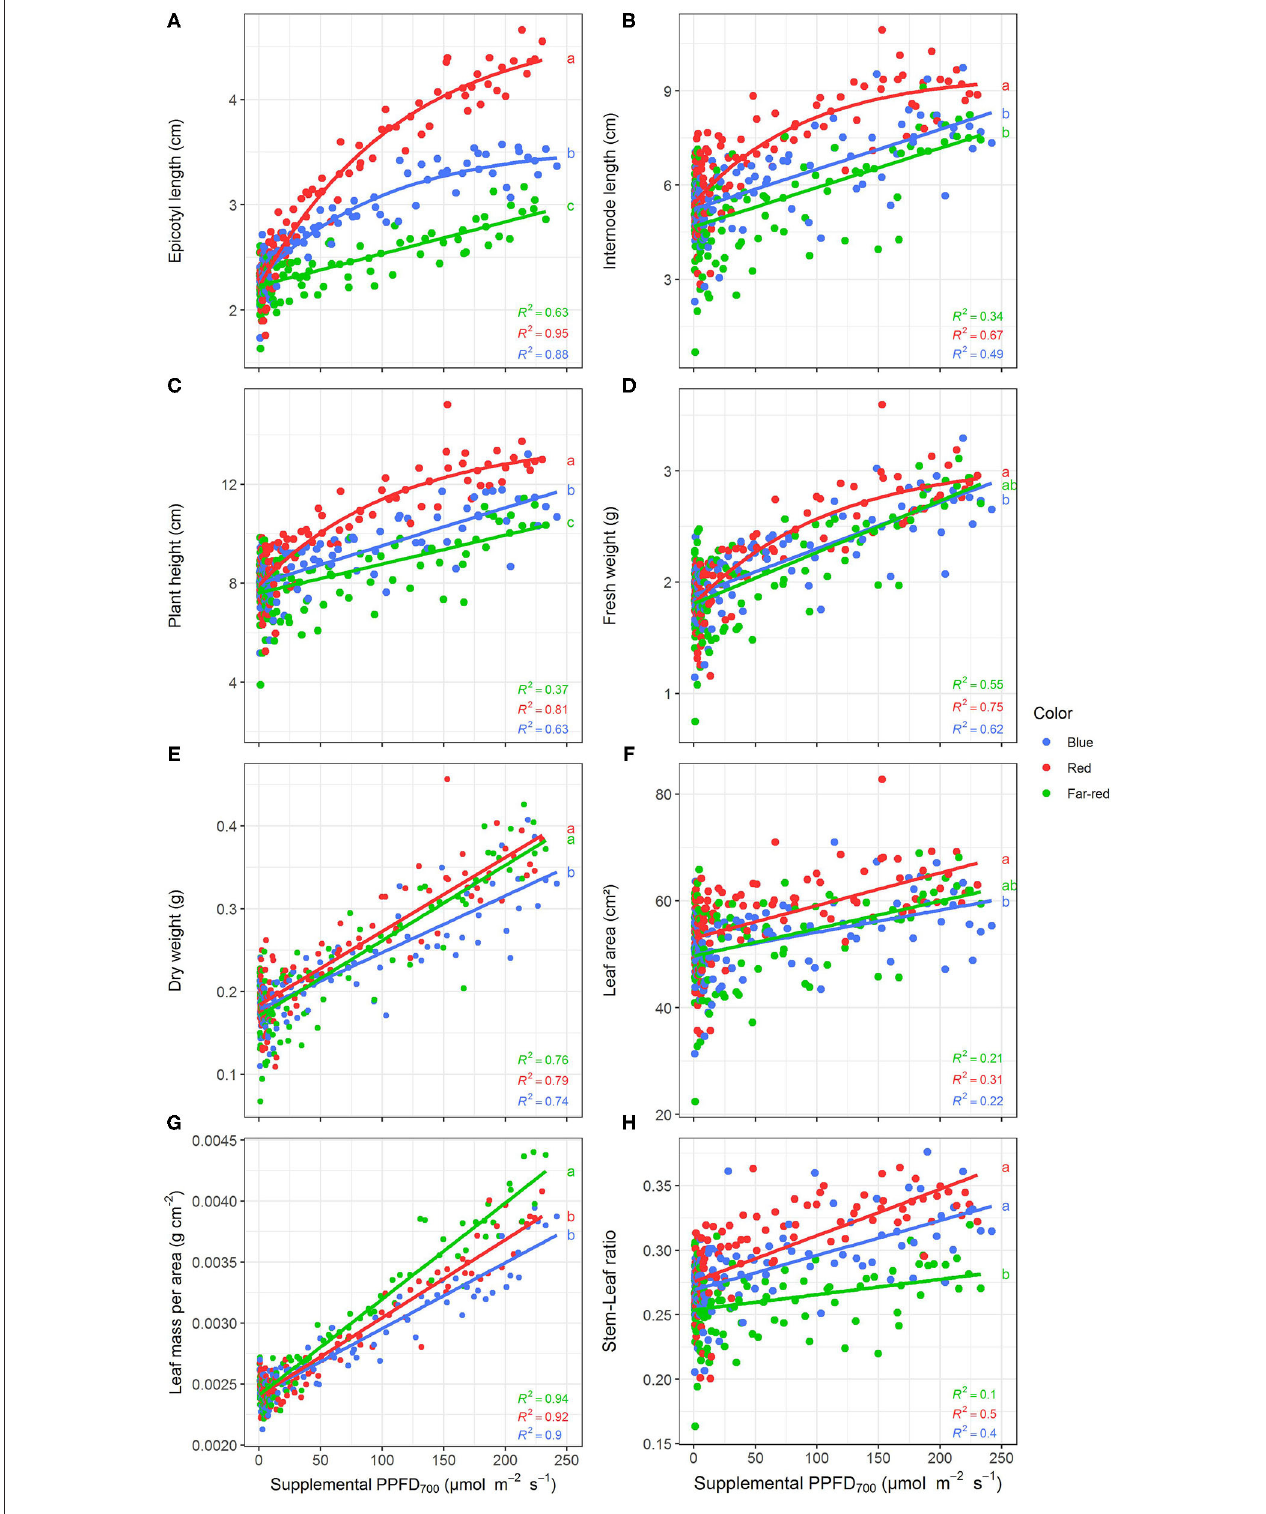
FIGURE 3 | Effect of supplemental PPFD 700 (400–700nm) with different spectra on epicotyl length (A) , total internode length (B) , height (C) , fresh weight (D) , dry weight (E) , leaf area (F) , leaf mass per area (G) , and stem-leaf ratio (H) of Ocimum basilicum L. cv. “Edwina” cultivated under greenhouse conditions.